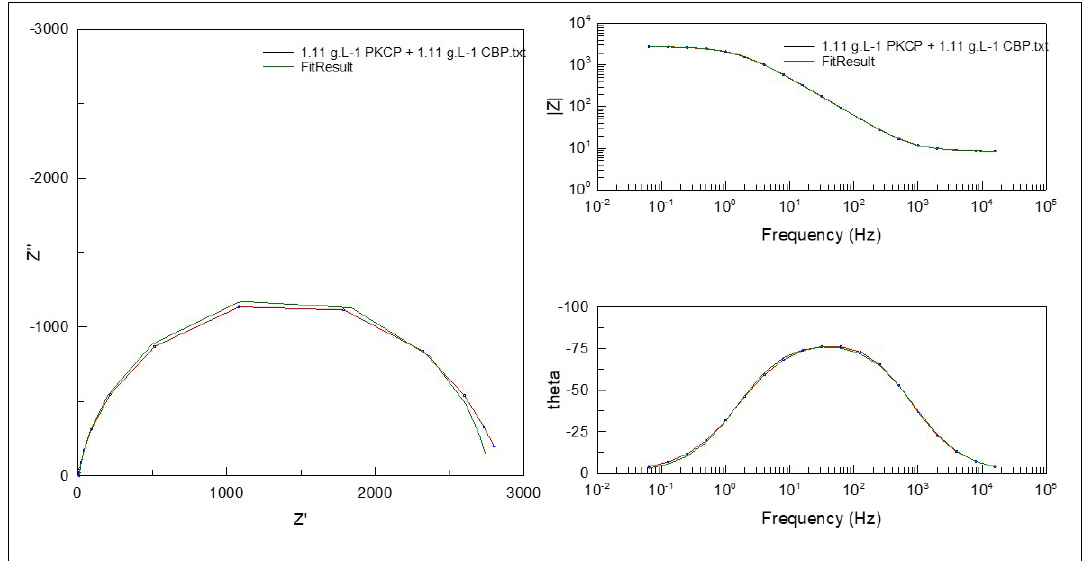
Figure 7. Z-View software interface for the adjustment of electrochemical impedance data (in the presence of 1.11 g.L -1 PKCP + 1.11 g.L -1 CBP of inhibitor) to the equivalent electrical Table 2. Parameters from the fitting EIS diagrams with the equivalent circuit of Figure 6. Concentration (g.L -1 )